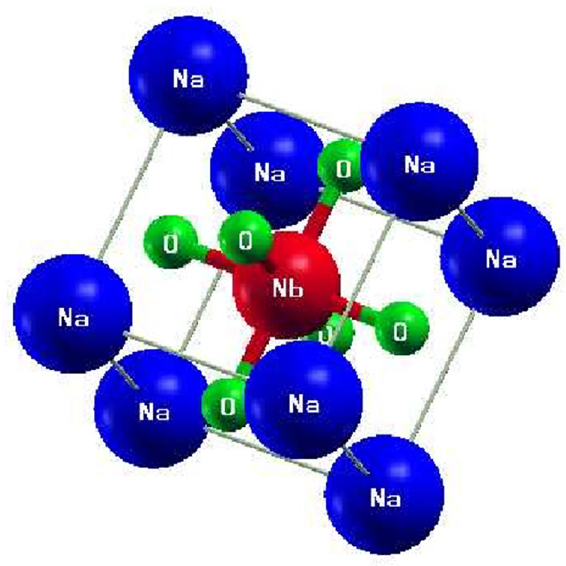
Figure 1. (Color online) A simple cubic structure of alkali (Na)-based niobate (NaNbO 3 ): the blue-, red- and green-colored spheres represent sodium, niobium, and oxygen, respectively. The structure of alkali (Na)-based tantalate (NaTaO 3 ) is like this one where Na is replaced by Ta.